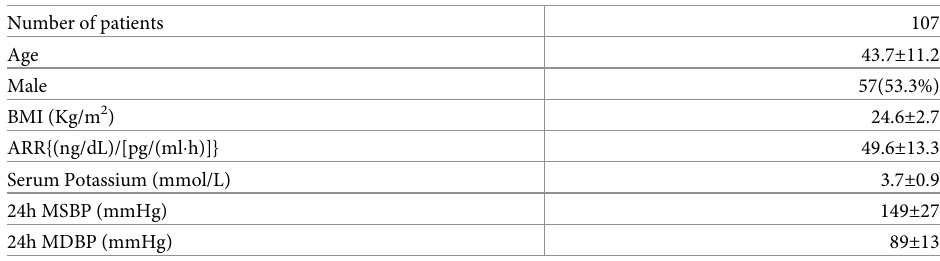
Table 1. Patients characteristics.